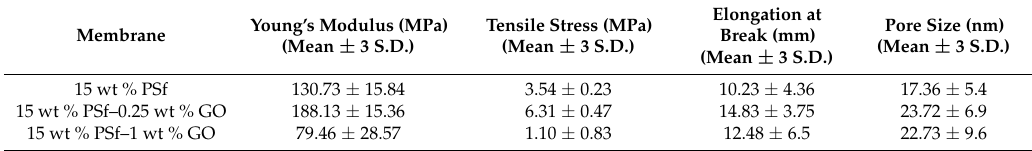
Table 2. Characterization of prepared membranes.